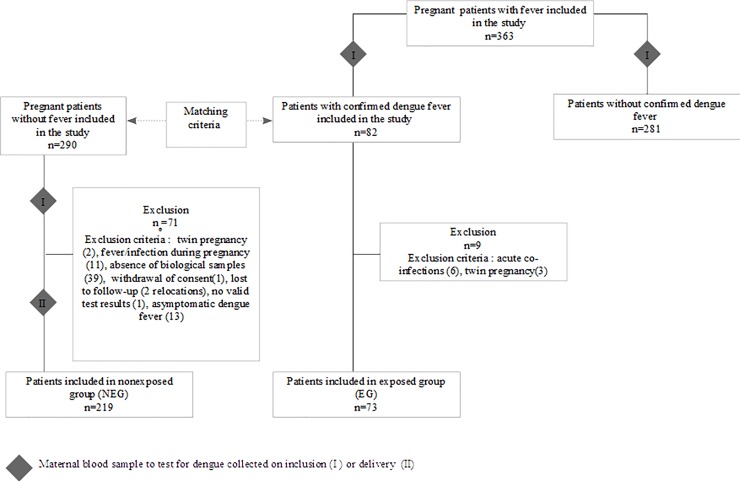
Study flow chart.